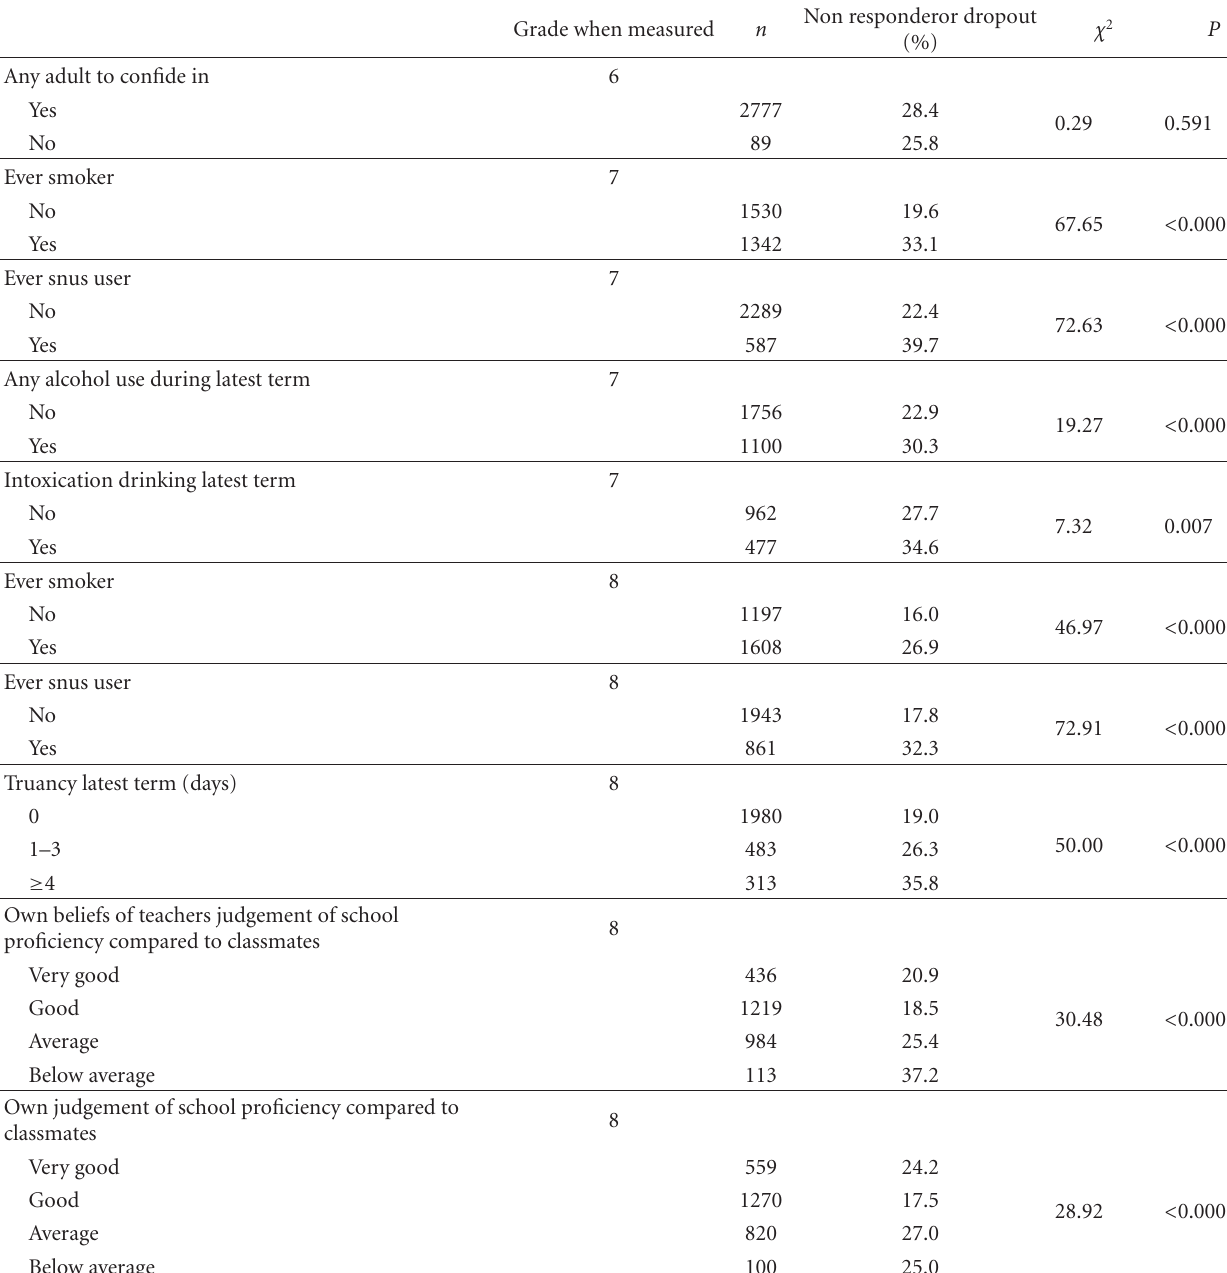
Table 3: Behavioural and psychosocial characteristics at followup as predictors of subsequent non-participation. Grade when